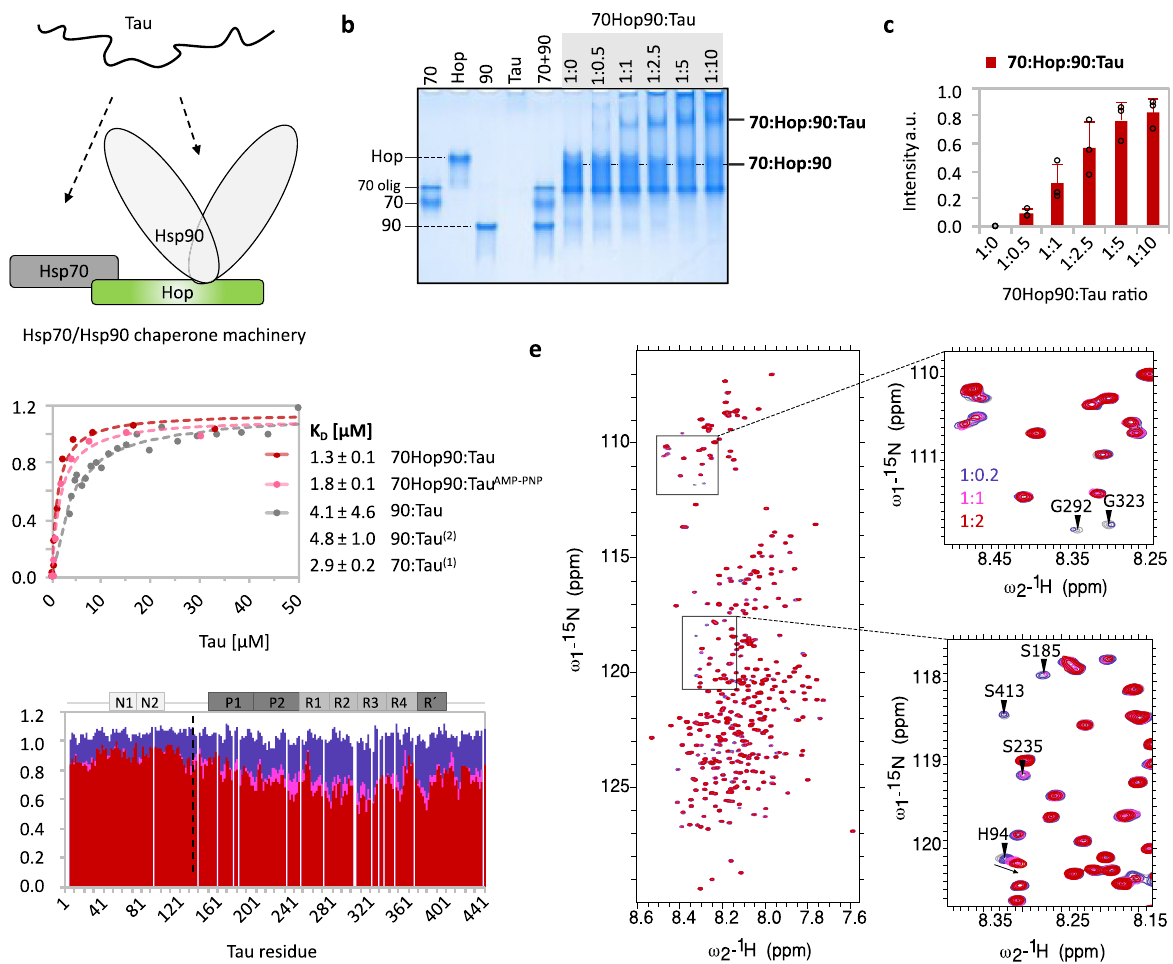
Fig. 1 Tau is a high-af fi nity substrate of the Hsp70/Hsp90 chaperone machinery. a Cartoon representation of Tau interacting with the Hsp70/Hsp90 chaperone machinery. b Native PAGE analysis of the Hsp70:Hop:Hsp90 complex (1:1:1 molar ratio) with increasing concentrations of Tau. Hsp70 and Hsp90 are abbreviated as “ 70 ” and “ 90 ” , respectively. For Hsp70, a fraction of the protein was oligomeric (labeled as “ 70 olig ” ). c Quantitative analysis of the band intensities from ( b ). Data are presented as mean ± the standard deviation (SD) from three independent experiments. d Tau af fi nities for the Hsp70/Hsp90 chaperone machinery in the absence (red) and presence of AMP-PNP (rose), as well as for the individual chaperones Hsp70 and Hsp90 reported previously (2),(1) 40,64 and con fi rmed for the Hsp90:Tau interaction (gray). Errors represent SD from three independent experiments (70Hop90:Tau) or standard error of the nonlinear fi t (70Hop90:Tau AMP-PNP and 90:Tau). e 2D 15 N- 1 H HSQC spectra of Tau alone (gray) and with increasing concentrations of the Hsp70:Hop:Hsp90 complex (1:1:1 molar ratio) using Tau:machinery molar ratios of 1:0.2 (purple), 1:1 (pink) and 1:2 (red). f NMR interaction pro fi le observed in ( e ) (same color code). I 0 are the peak intensities of unbound Tau (gray spectrum in ( e )). The black dotted line marks the distinction between fast (to the left) and intermediate-to-slow exchange (to the right) referring to low and high af fi nity, respectively. Tau domains are indicated on top. Source data are provided as a source data fi